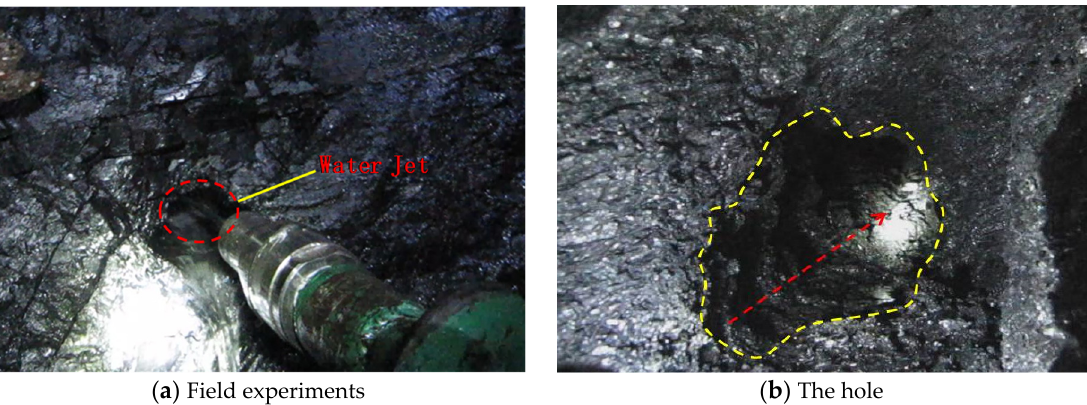
Figure 18. Coal breaking and punching experiment. Table 9. Experimental results of coal breaking and punching before and after nozzle optimization. Structural Parameters Punching Depth Experimental Group